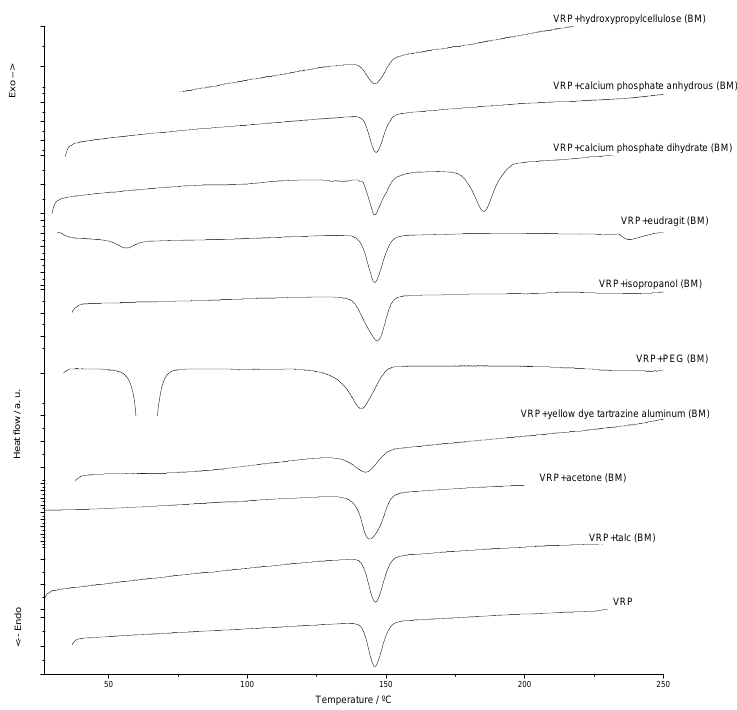
Figure 1. DSC curves for verapamil hydrochloride and its binary mixtures (BM,